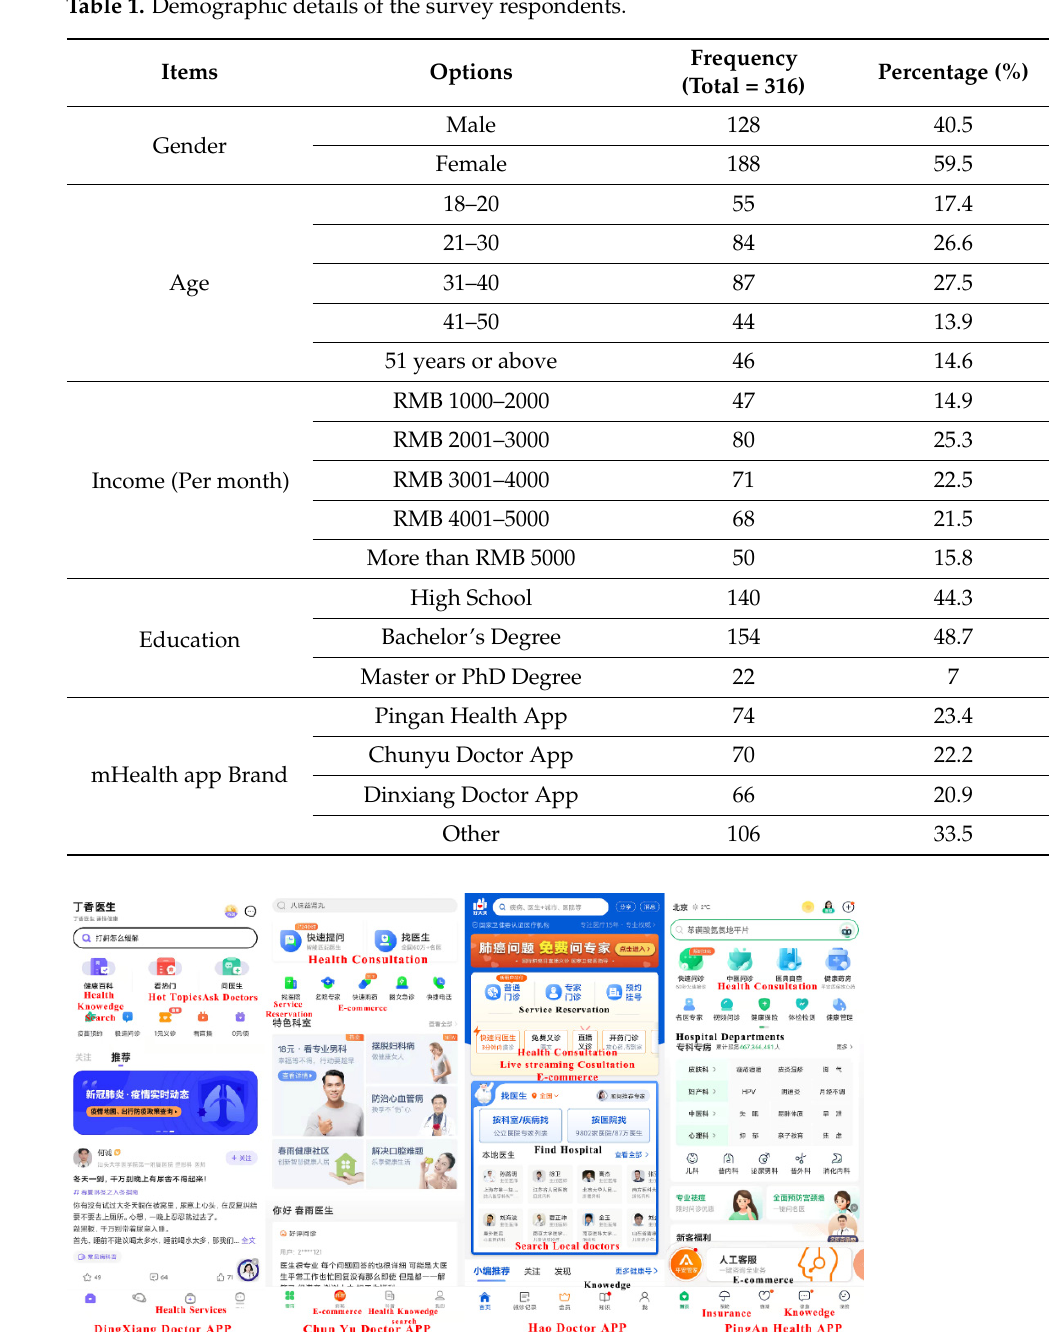
Table 1. Demographic details of the survey respondents.